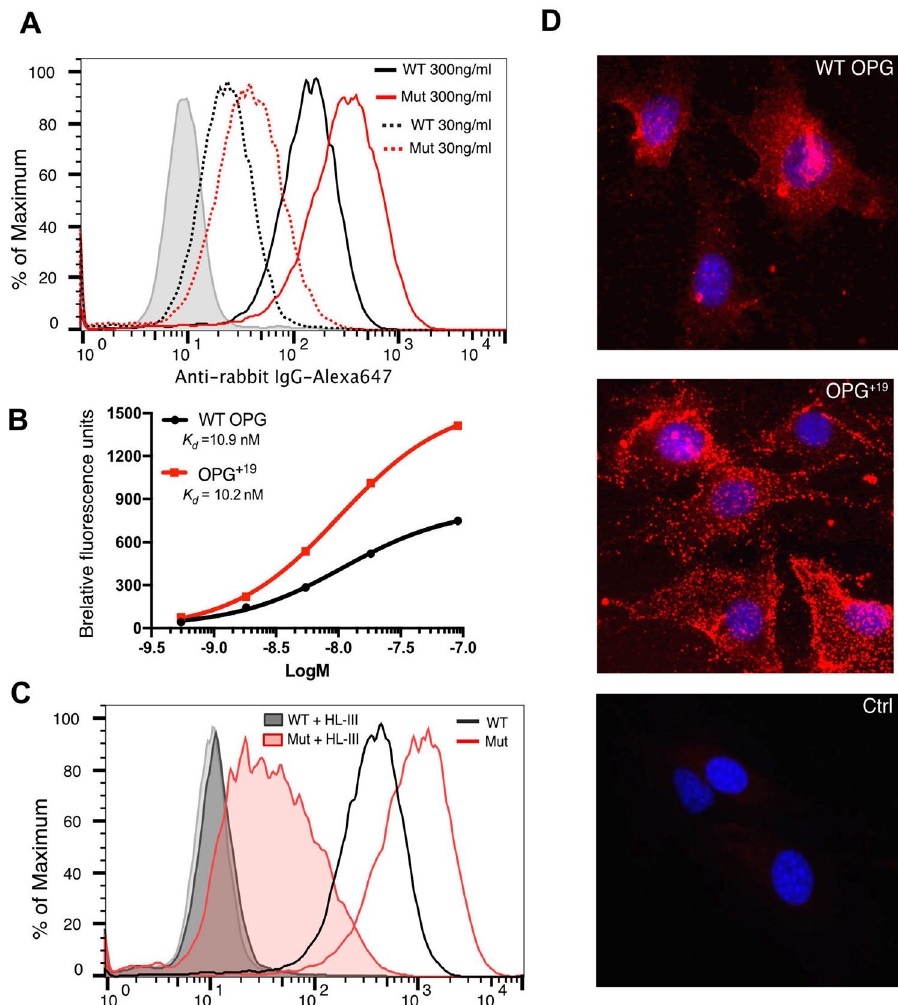
Figure 3. OPG +19 preserves HS-binding capacity. ( A ) Binding of WT and mutant human OPG (30 ng/ml and 300 ng/ml) to MC3T3 cells were determined by a FACS-based binding assay. The bound OPG were detected by staining with a rabbit anti-OPG antibody, followed by anti-rabbit-IgG–Alexa647. The shaded histogram is from cells stained only with primary and secondary antibodies. ( B ) Apparent binding affinity of WT OPG and OPG +19 to MC3T3 cells was determined by FACS. Concentration of OPG tested were between 30 ng/ml and 5 µg/ml. ( C ) Binding of WT and mutant OPG (100 ng/ml) to untreated MC3T3 cells or cells pretreated with heparin lyase III (HL-III, shaded histogram) ( D ) OPG +19 display a unique binding pattern to osteoblast surface HS. MC3T3 cells were incubated with either WT or mutant OPG, both at 300 ng/ml. Bound OPG were detected with 0.1 μg/ml rabbit anti-OPG, followed by goat anti-rabbit-594. Magnification =